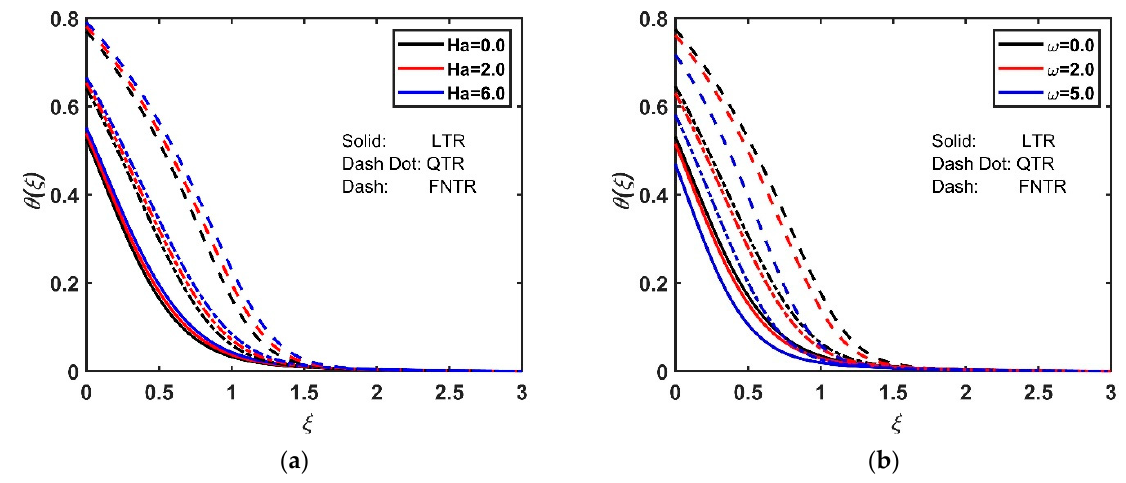
Figure 2. Impact of ( a ) 𝐻𝑎 on 𝜃(𝜉) , and ( b ) 𝜔 on 𝜃(𝜉) for the LTR, QTR and FNTR cases.